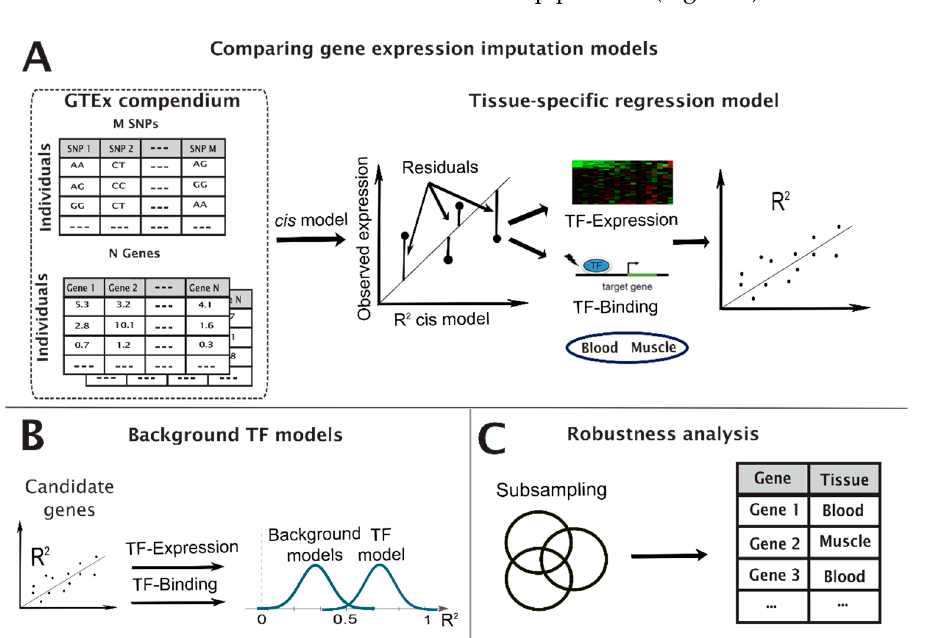
Figure 1. Illustration of the filtering pipeline to identify TF hit genes. We computed the baseline cis model and compared them with one of the three TF models to identify candidate genes per TF model ( A ), computed a background model for each of the candidate genes to test their significance ( B ), and conducted a robustness test to validate the results ( C ).